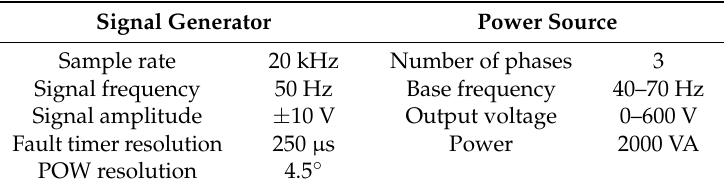
Table 5. Basic properties of the signal generator and the power